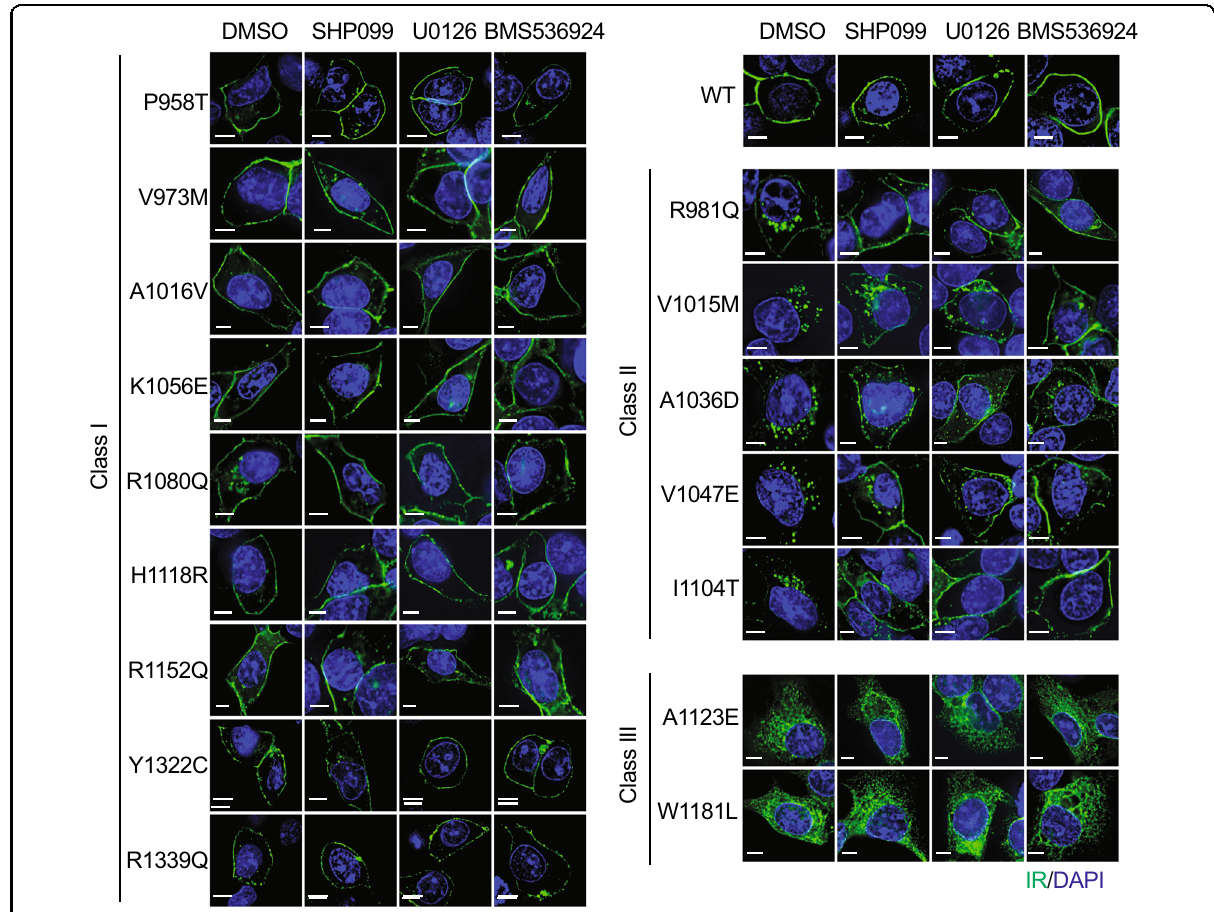
Fig. 3 Characterization of IR mutations found in human patients. HepG2 cells expressing IR-GFP wild-type (WT) or mutants were starved for 14 h, treated with the indicated inhibitors for 4 h, and stained with anti-GFP (IR; green; 1181446001, Sigma) and DAPI (blue). SHP099 (SHP2 inhibitor, 10 μ M, MedChemExpress), U0126 (MEK inhibitor, 40 μ M, Cell Signaling), and BMS536924 (IR kinase inhibitor, 2 μ M, Tocris). Scale bar, 5 μ